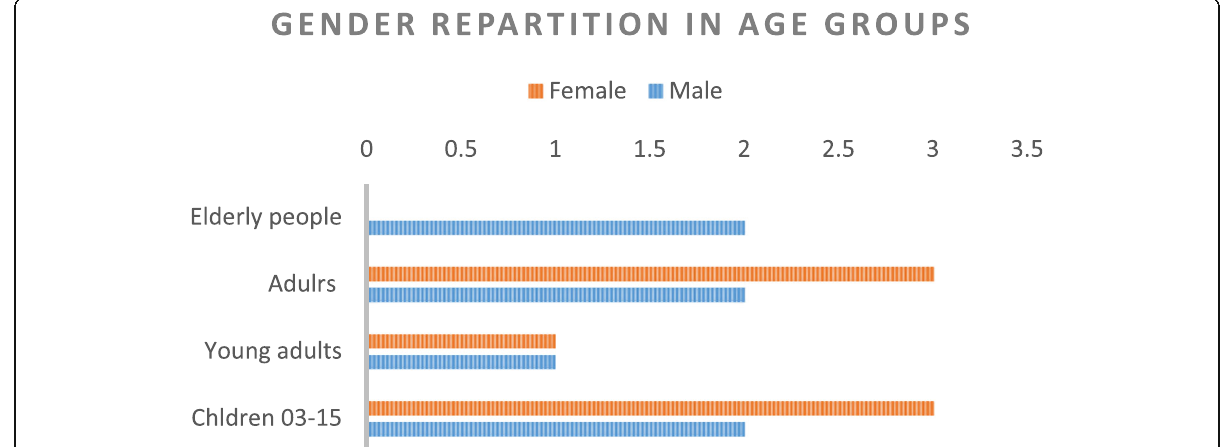
Fig. 6 Gender repartition in age groups in patients with bilateral antrochoanal polyp [8 –